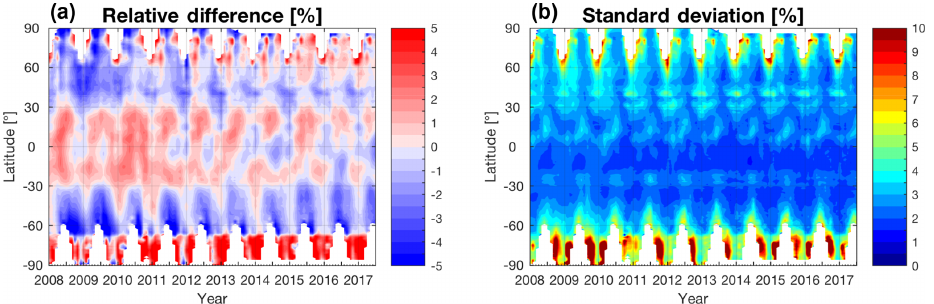
Figure 6. (a) Relative differences (in percent) between IASI-A and GOME-2A for 1 ◦ zonal monthly mean total ozone columns during the 2008–2017 period; (b) the associated standard deviation (in percent). The relative difference is calculated as 100 × (IASI-A − GOME- 2A) /